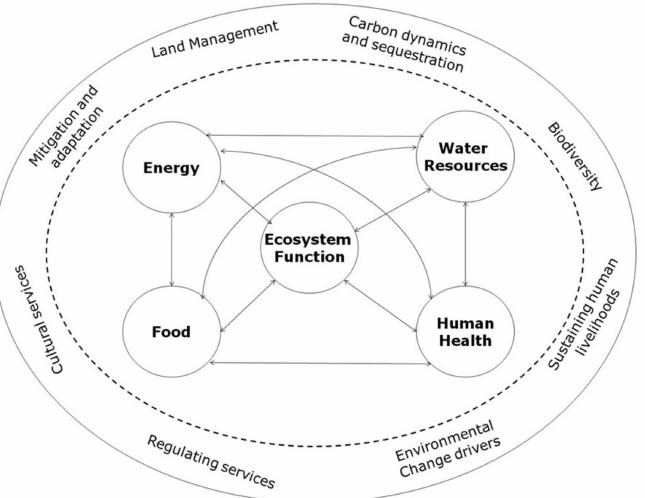
Figure 6. Schematic of the relation of ecosystem contextual vulnerability to the spectrum of the environmental forcings and feedbacks. The arrows denote nonlinear interactions between and within natural and human forcings from